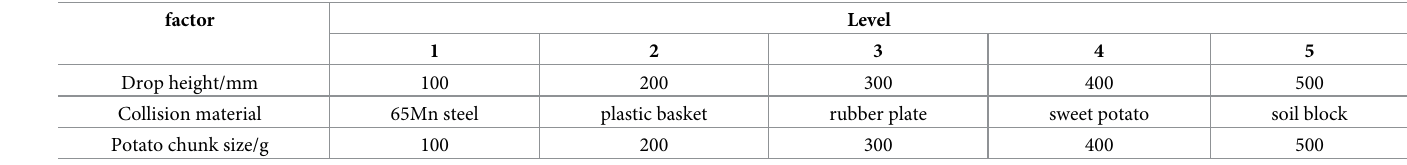
Table 2. Levels of test factors.